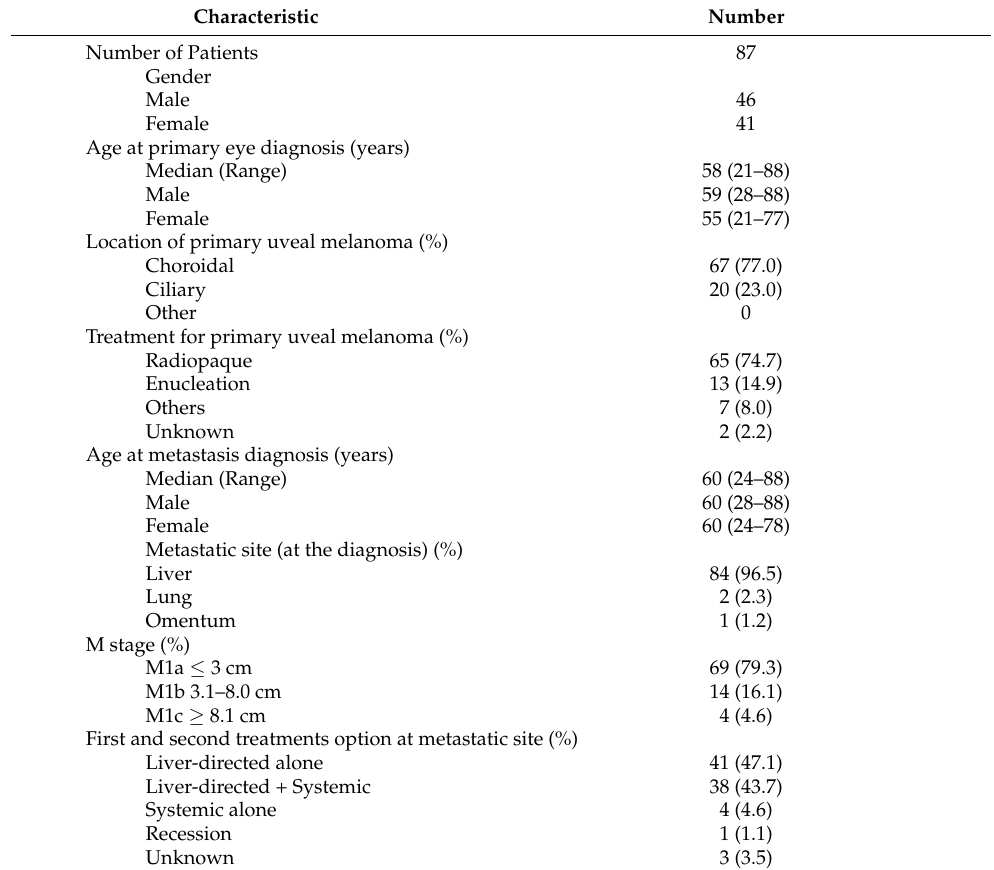
Table 1. Demographic features of UM patients with